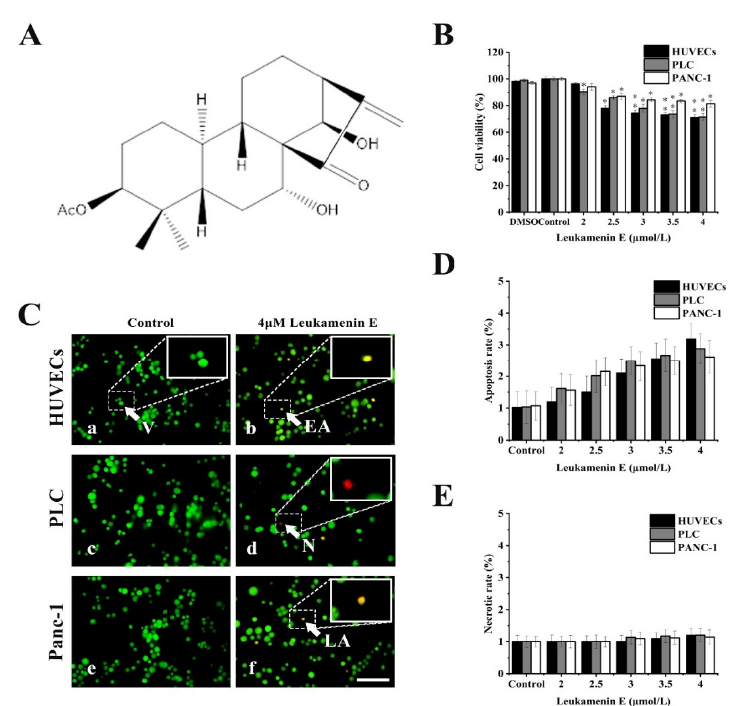
Figure 1. Effects of leukamenin E on proliferation and apoptosis in human umbilical vein endothelial cells (HUVECs), primary liver carcinoma cells (PLC), and Panc-1 cells. ( A ) Chemical structure of leukamenin E. ( B ) Cell viability assay of HUVECs, PLC, and Panc-1 treated with leukamenin E (2 μM- 4 μM) for 24 h based on MTT. ( C ) Evaluation of apoptosis of HUVECs (a,b), PLC (c,d), and Panc-1(e,f) cells treated with leukamenin E by acridine orange/ethidium bromide (AO/EB) double staining. Four types of cells were observed by AO/EB staining: viable cells (V), early apoptotic cells (EA), necrotic cells (N), and late apoptotic cells (LA), as indicated by the arrows in the pictures. Bar, 40 μm. ( D ) Apoptotic rate in HUVECs, PLC, and Panc-1 cells treated with leukamenin E for 24 h. ( E ) Necrotic rate in HUVECs, PLC, and Panc-1 cells treated with leukamenin E for 24 h. Images represent typical cells from at least three independent experiments. The data shown represent the means ± standard deviation (S.D.) of three independent experiments. * p < 0.05, νersus the control group.